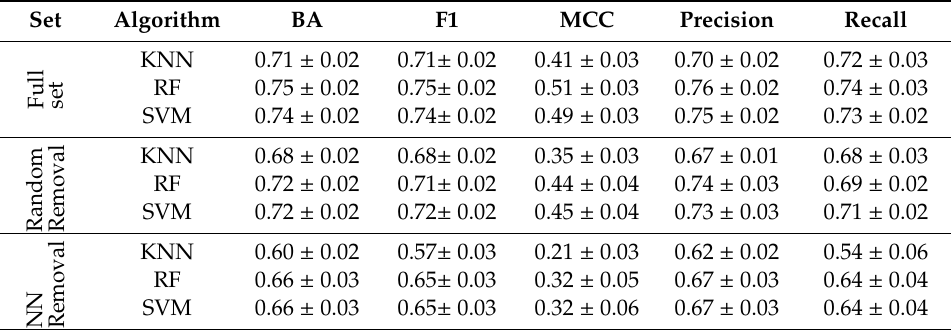
Table 5. Prediction accuracy for single- versus multi-target compounds from mixed assays. Set Algorithm BA F1 MCC Precision Recall ll u e F s